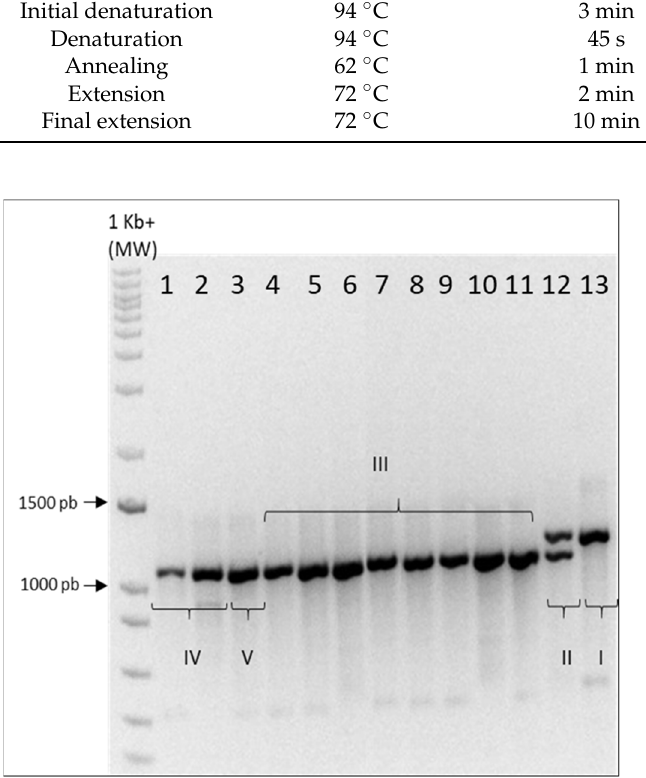
Figure A1. Chemotype determination. The respective chemotypes are indicated for each genotype (I–V). From left to right the genotypes are: 1, Santhica 27; 2, Bernabeo; 3, Ermo; 4, Fibranova; 5, Eletta Campana; 6, Futura 75; 7, Carmagnola; 8, Carmaleonte; 9, Codimono; 10, C.S.; 11, Fibrante; 12, CINRO; 13,